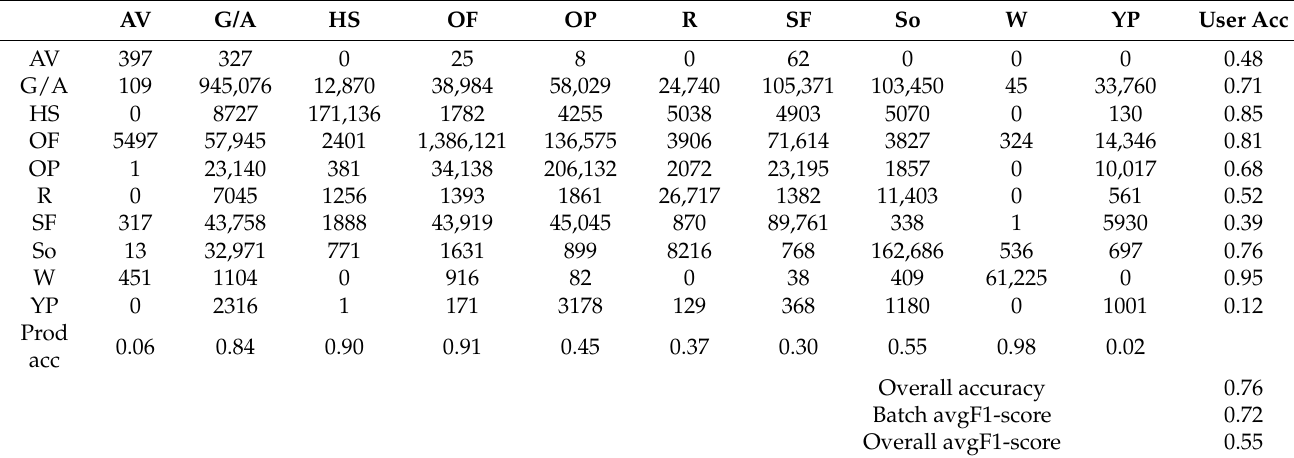
Table A2. Confusion matrix for the validation set using the MS U-net. Rows show predicted classes while column, ground truth classes. LULC abbreviations: AV, aquatic vegetation; G/A, grasslands/agriculture; HS, human settlements; OF, old-growth forests; OP, old-growth plantations; R, roads; SF, secondary forest; So, soil, W, water; YP, young plantations. User acc stands for user’s accuracy, while Prod acc for producer’s accuracy.